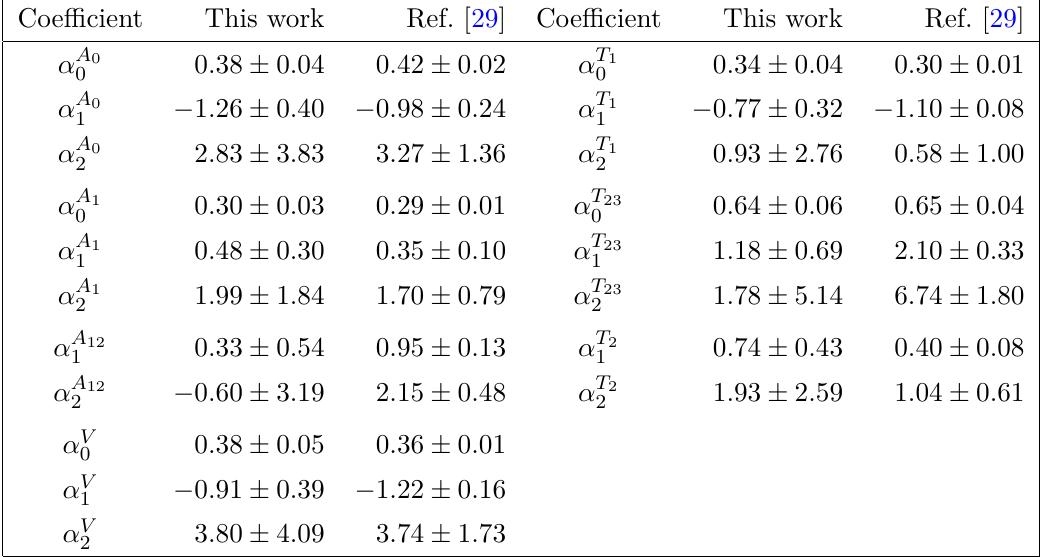
Table 11 . Posteriors of the B s → φ local FFs fit. We used the exact relations (A.24)–(A.25) to reduce the number of parameters to 19. The posterior distribution is accurately described with a single multivariate Gaussian distribution, whose parameters are given in the ancillary file BsToPhi-local.yaml . We compare our results to those of ref.